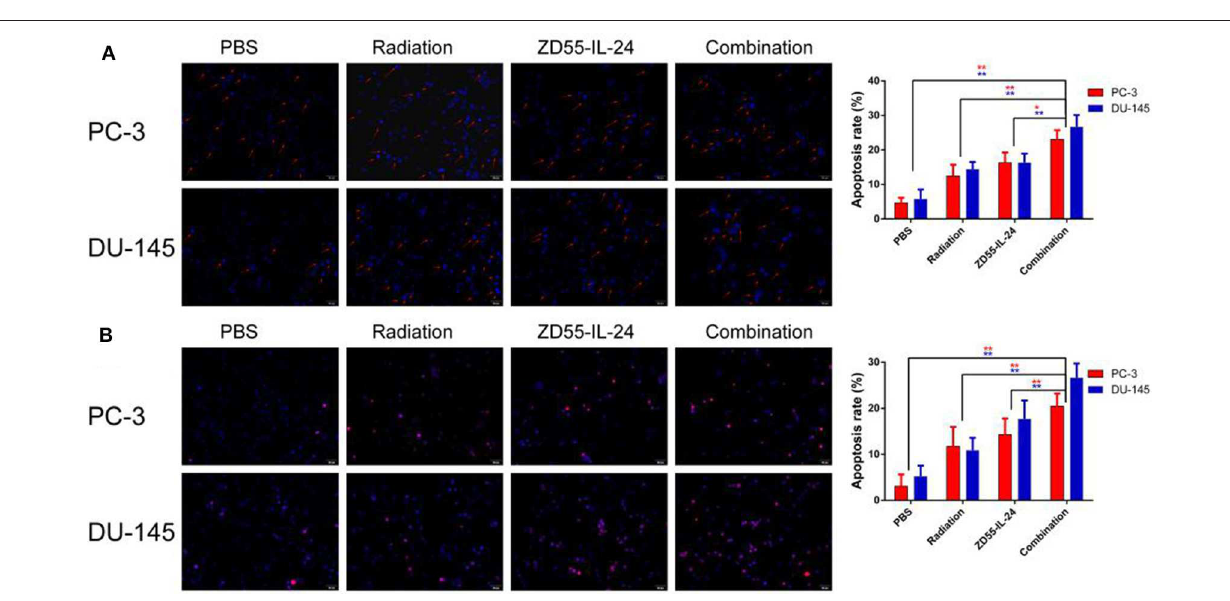
FIGURE 2 | The apoptosis of PC-3 and DU-145 cells exposed to ZD55-IL-24 or/and radiation. (A) Hoechst-33258 staining showed the apoptosis rate of PC-3 and DU-145 cells in each group (200 × ). (B) TUNEL assay showed the apoptosis rate of PC-3 and DU-145 cells in each group (200 × ). ** P < 0.01 vs. combination group.